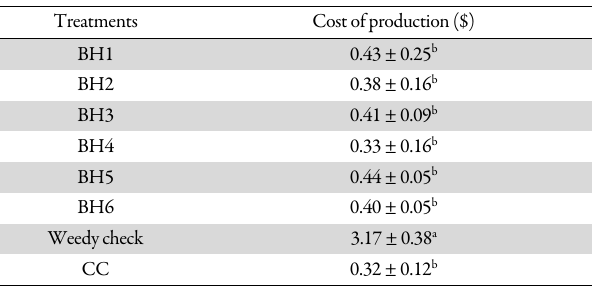
Table 4. Cost of production of each treatment used for the control of weed in maize